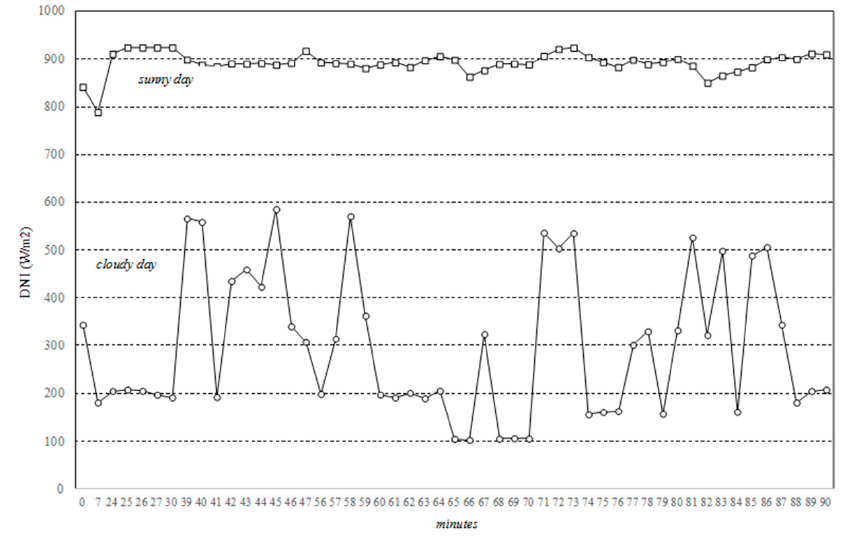
Figure 10. Experimental trend of the DNI for a sunny day and a cloudy day.